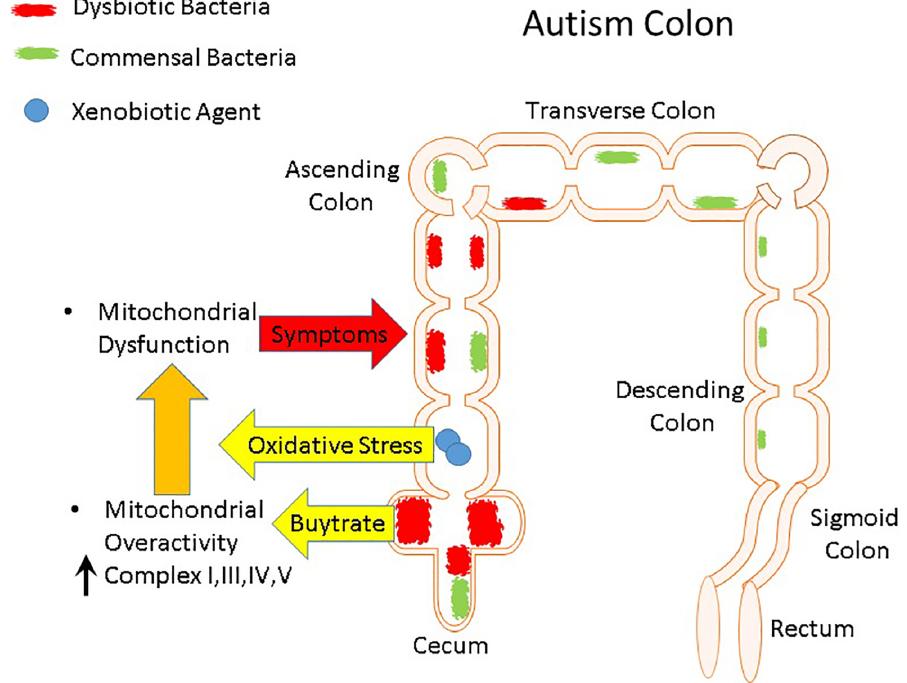
Fig 6. Synthesis of findings of the study. Dysbiotic bacteriain the gastrointestinal tract of individuals with autism producebutyrate that drives the mitochondria to become overactiveand very sensitive to oxidative stress. Xenobiotic agents (see previous review [35]) can increase oxidativestress through inflammation or by their intrinsicnature. This results in mitochondrial dysfunction that can contribute to gastrointestinal symptoms such as dysmotility (arrow symbol from mitochondrial dysfunctionto